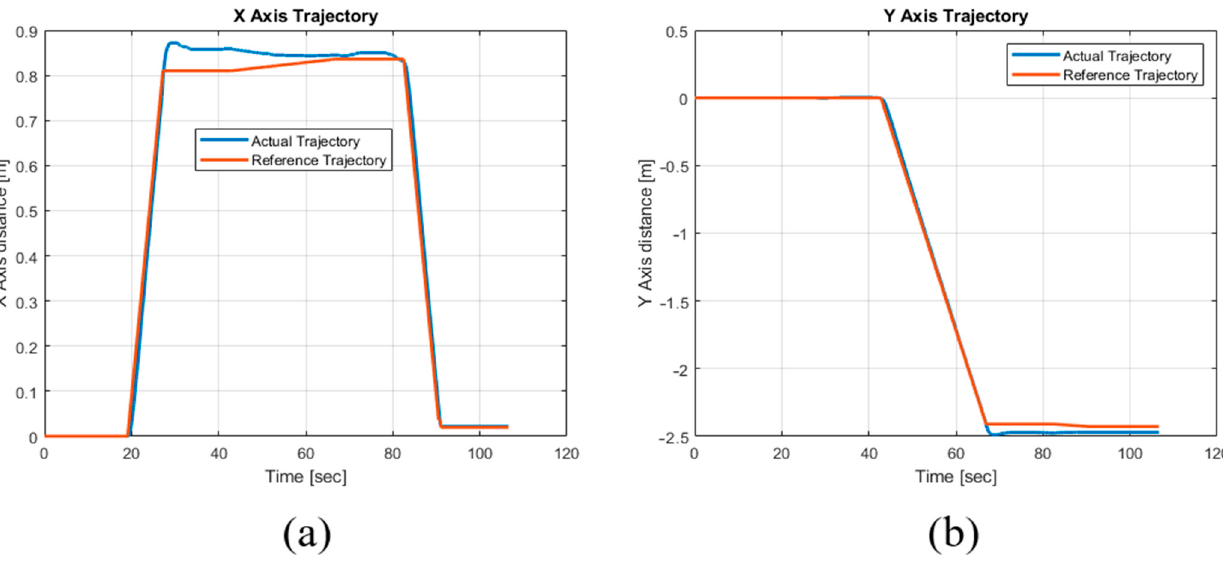
Figure 21. ARS PeopleBot trajectory: ( a ) X axis; ( b ) Y axis Trajectories.